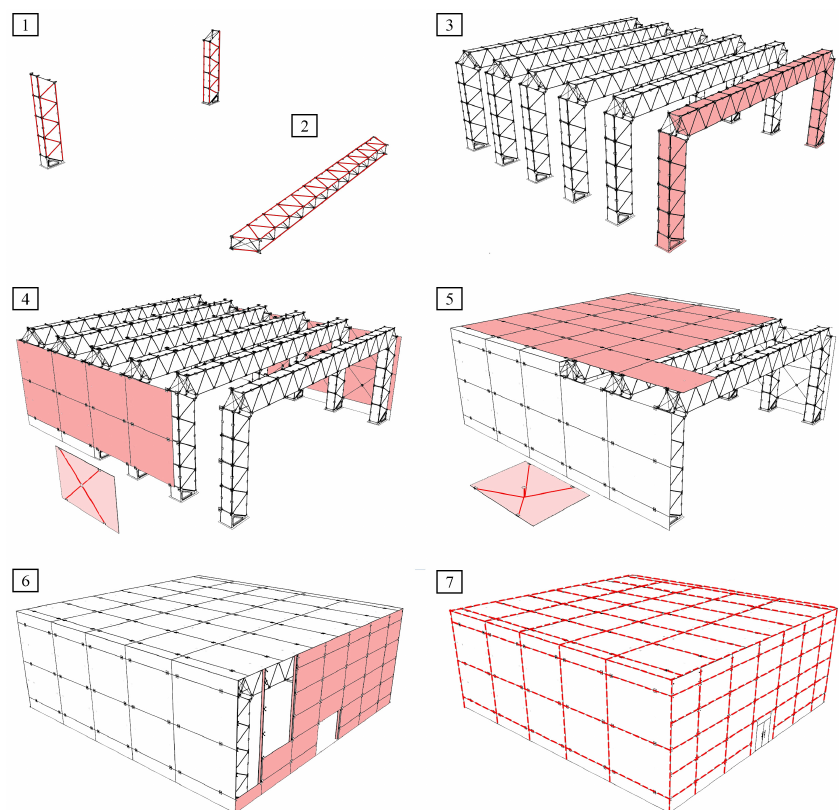
Figure 4. Installation sequence of the TVT Pavilion: 1 . Positioning and pre ‐ stress of the columns and 2 . the beam; 3 . assembly of the TVT portals; 4 . on ‐ site pre ‐ stress and installation of the vertical bracing panels and 5 . the horizontal bracing panels; 6 . assembly of the façade; 7 . edge sealants.